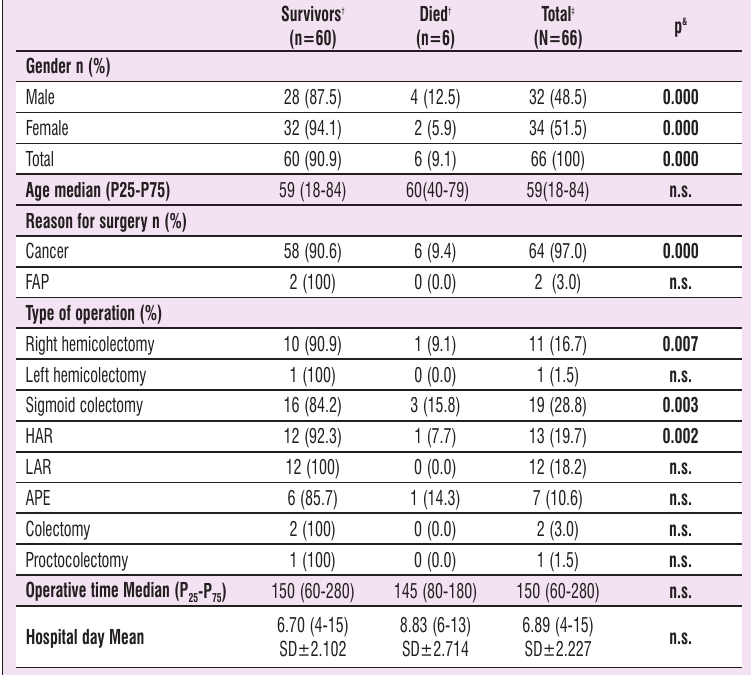
Table 1. Patient and surgery characteristics